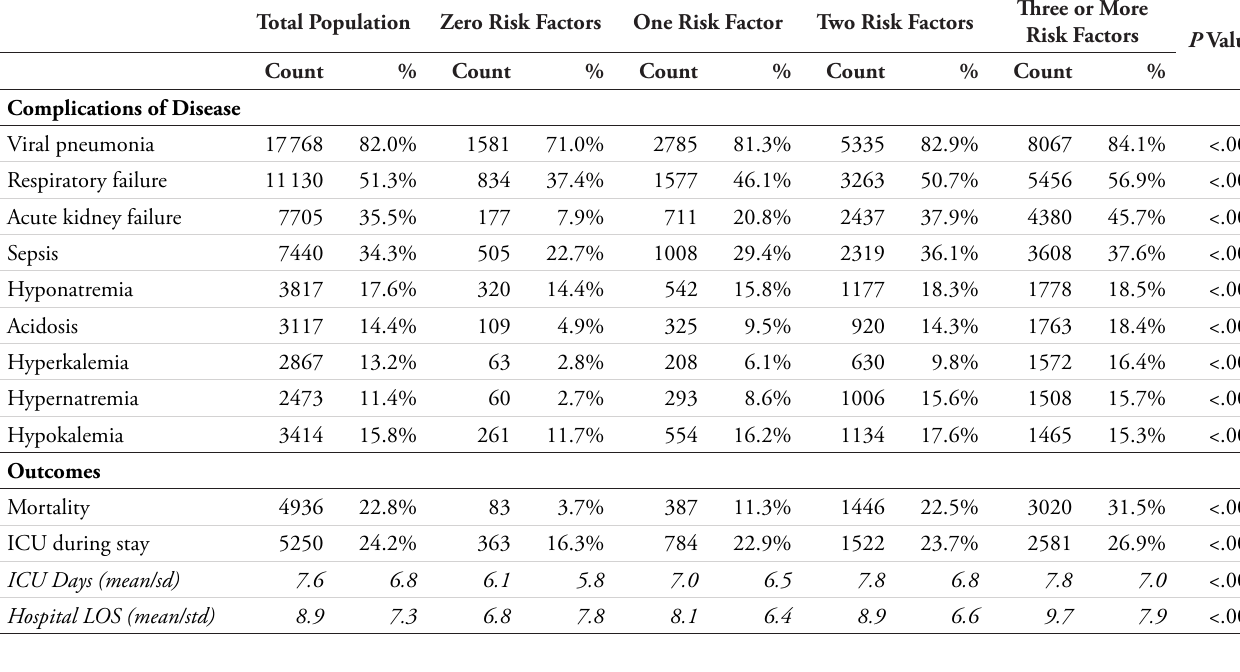
Table 3. COVID-19 Patient Complications and Outcomes by Number of Risk Factors